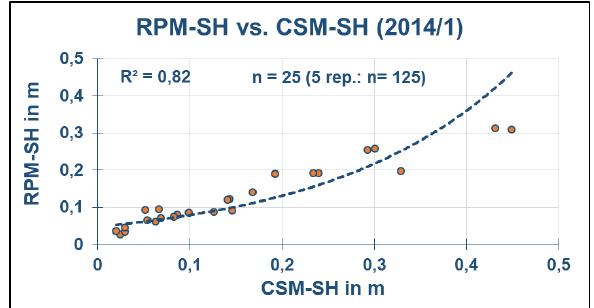
Figure 5. Relationship of RPM-SH and CSM-SH data The combination of CSM-SH and RGBVI data is considered in the Grass I according to Bareth et al. (2015) as the sum of both. In Fig.6 the correlation with the RPM-SH data is very high achieving a R 2 of 0.9.